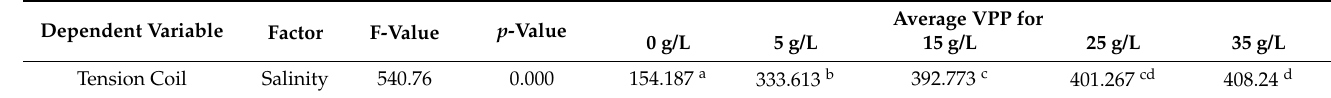
Table 2. Summary of ANOVA for salinity.